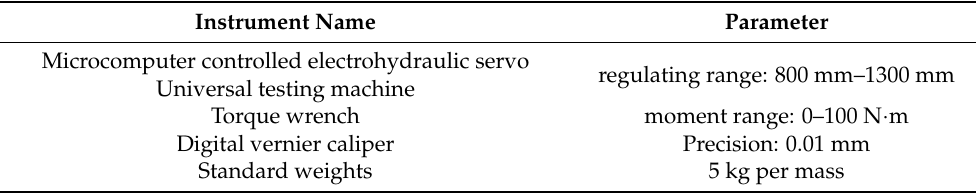
Table 1. Initial stiffness values of nodes under different working conditions.